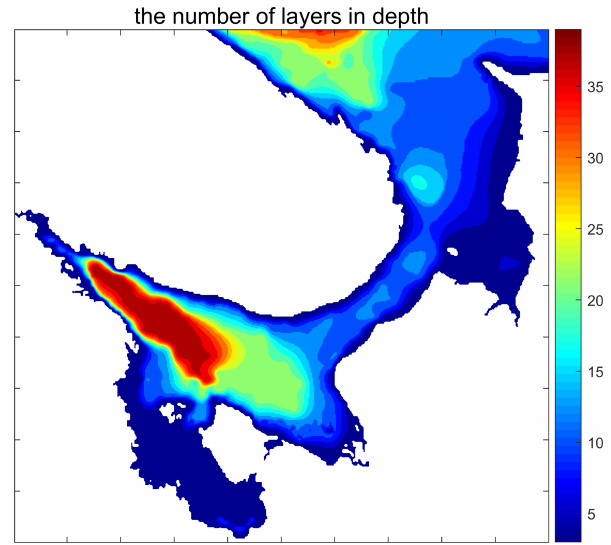
Figure 1. The number of depth layers in the White Sea model; the vertical grid step is 5m up to 150m deep and then 10m up to